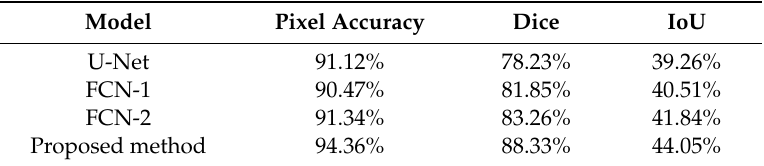
Table 1. Test accuracy of various U-Net